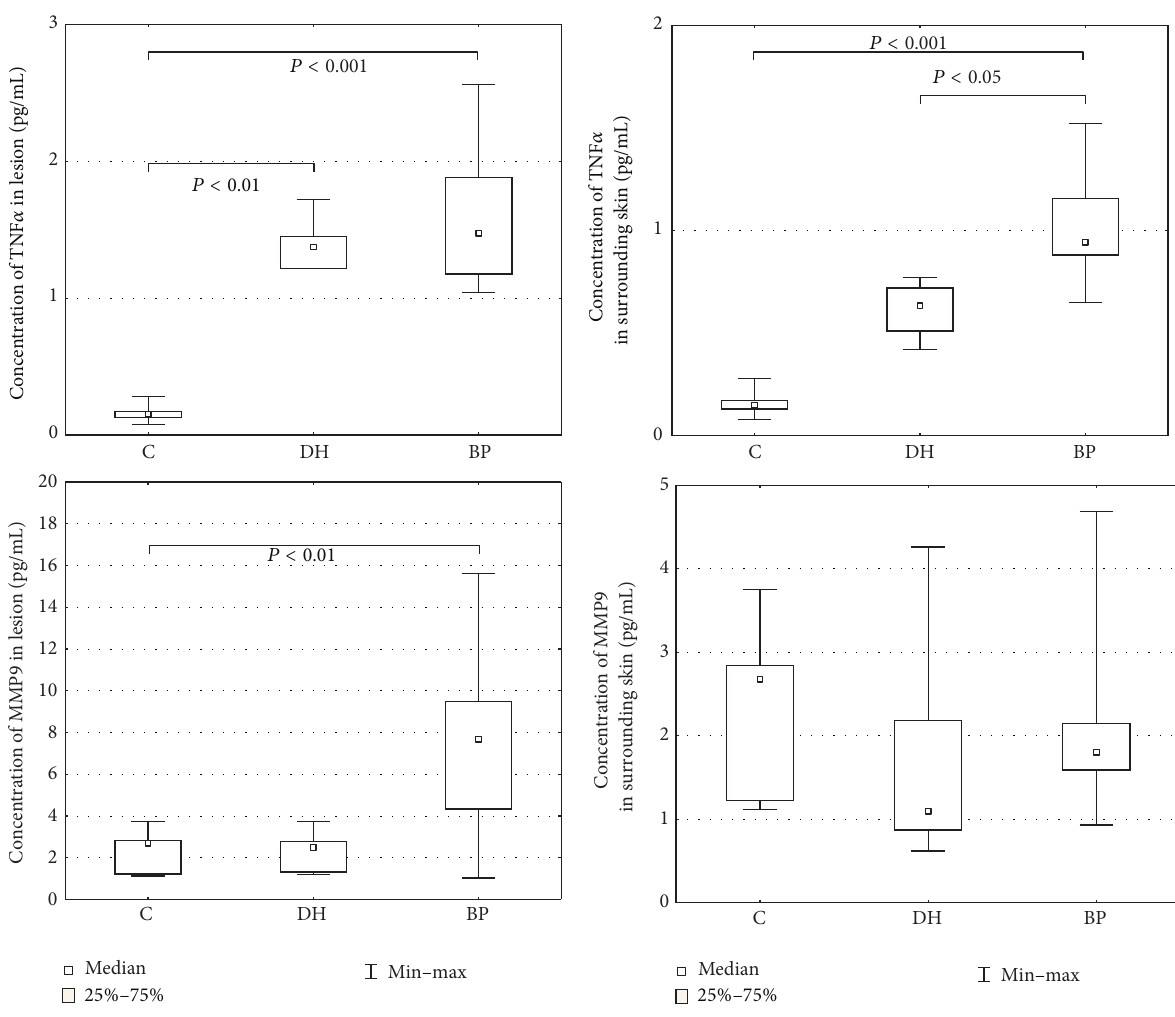
Figure 3: Morphometry of the immunoexpression of MMP9 and TNF 𝛼 , skin